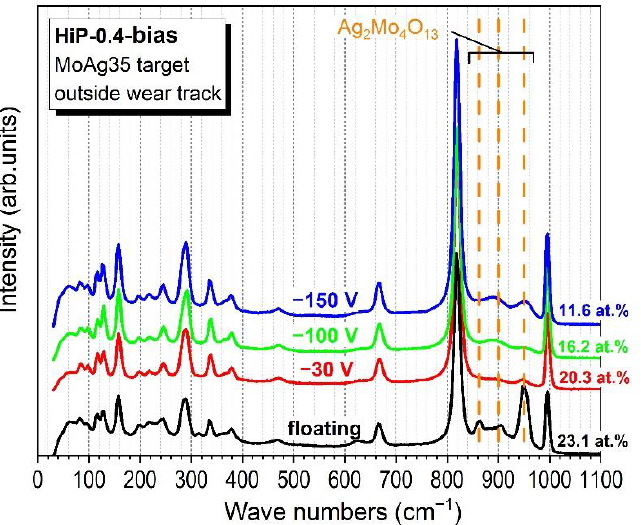
Figure 18. Micro Raman measurements. Spectra of the bias series (HiP-0.4-bias) taken outside the wear track of samples after HT tribotests with a laser spot size of 30 µm. The curves are labelled with the applied substrate bias and the Ag content on the right side.